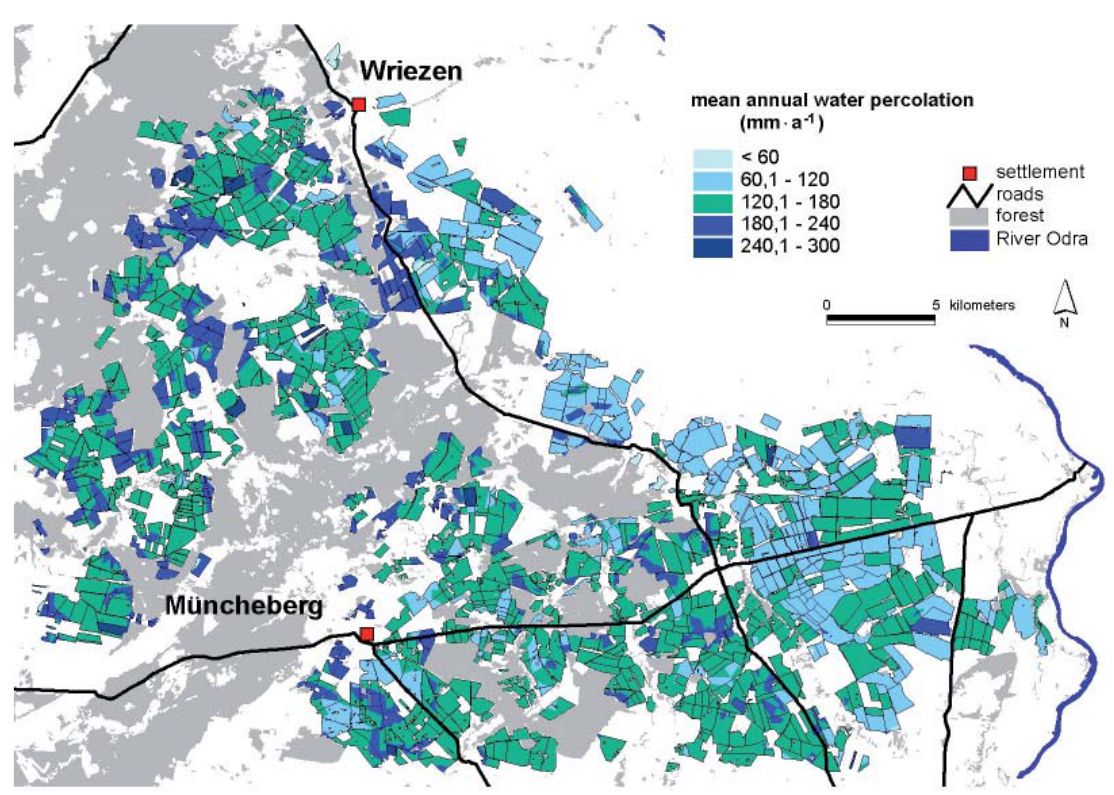
Figue 8. Mean annual water percolation of the Initial Situation